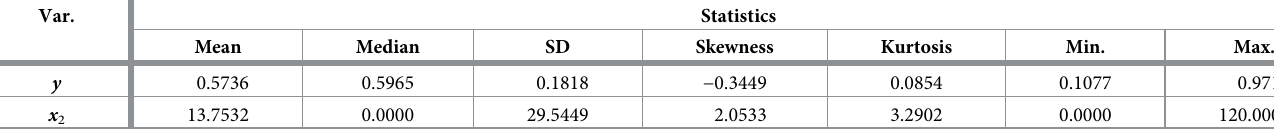
Table 4. Descriptive statistics from the response variable and quantitative covariates. Var.